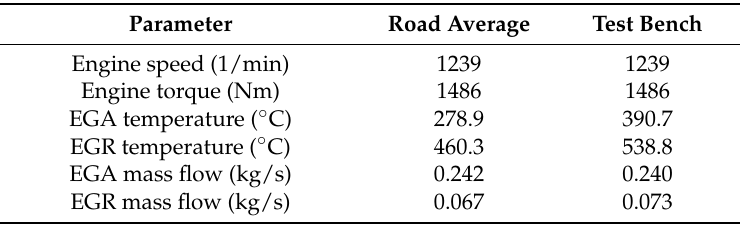
Table 1. Comparison of road average and steady state test bench boundary conditions, operating point 3. EGA: exhaust gas after-treatment; and EGR: exhaust gas recirculation.